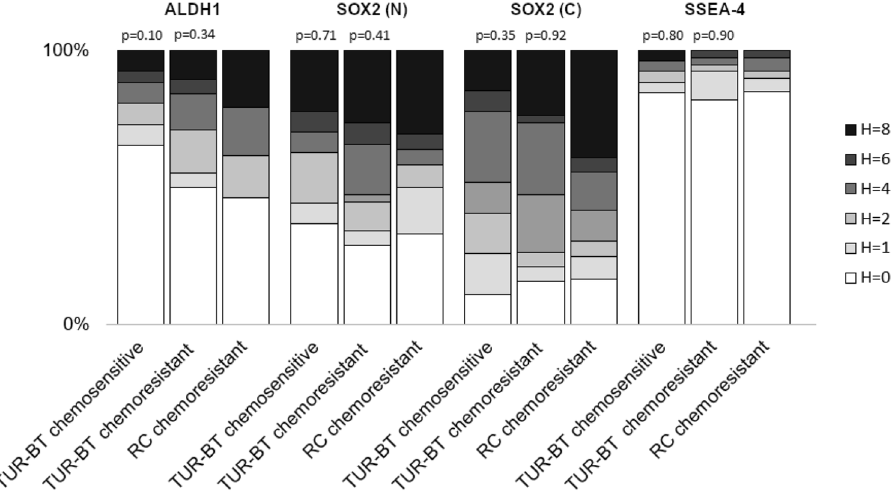
Figure 3. Distributions of H-scores before (TUR-BT) and after (RC) neoadjuvant chemotherapy. The first p-value denotes the statistical difference between TUR-BT chemosensitive and RC chemoresistant tumors while the latter denotes the statistical difference between TUR-BT chemoresistant and RC chemoresistant